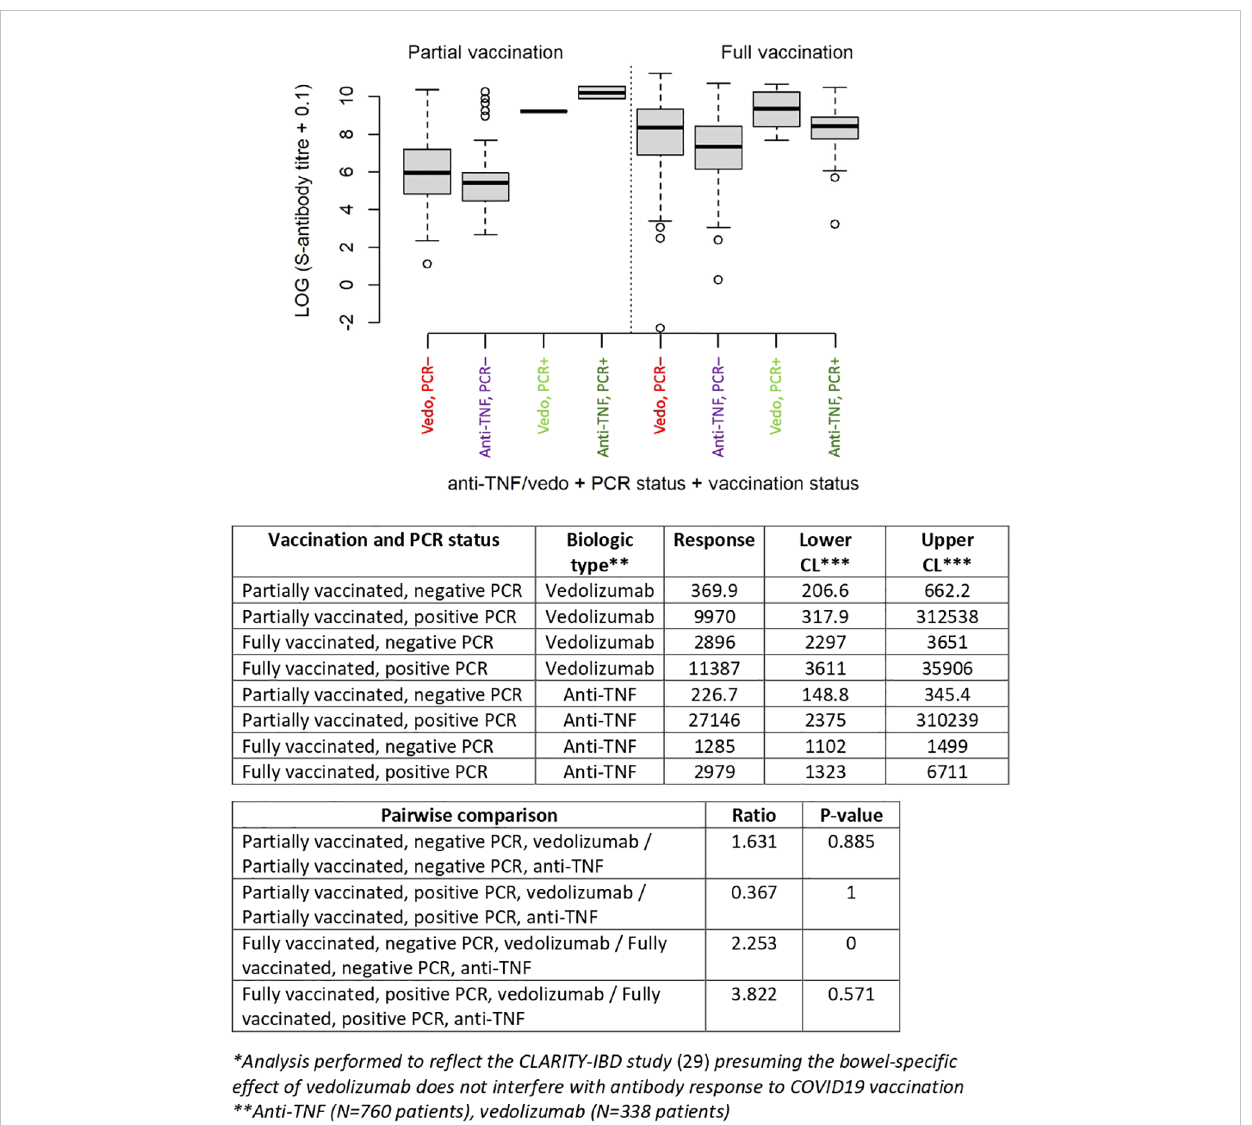
FIGURE 2 Anti-S-antibody titer (log-transformed) according to vaccination status, PCR status (positive or negative) and treatment modality (anti-TNF or